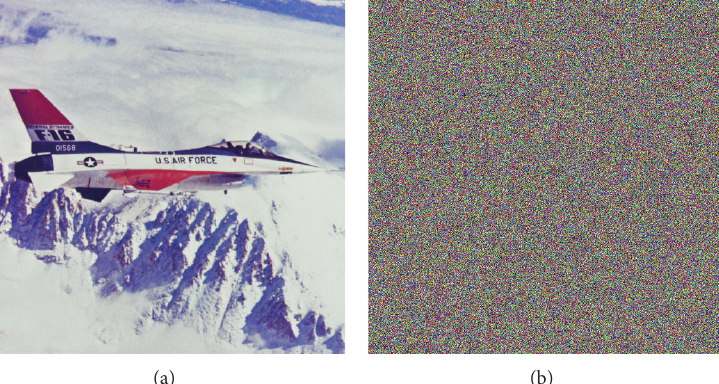
Figure 1: Comparison of the plain image and the encrypted image: (a) original picture 4.2.05 Airplane (F-16); (b) encrypted image of 4.2.05 Airplane (F-16).